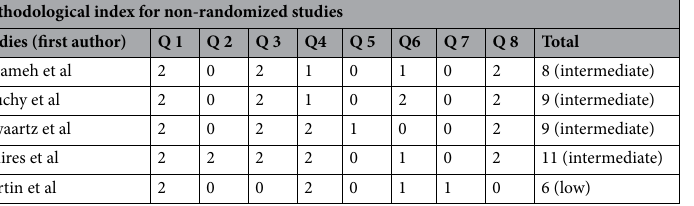
Table 3. Risk of bias assessment for included non-randomized studies. Q1 Did the study have a clear aim? Q2 Were consecutive patients included? Q3 Were data collected prospectively? Q4 Were endpoints appropriate to the study? Q5 Was there an unbiased assessment of endpoints? Q6 Was the follow-up period adequate? Q7 Was loss to follow-up less than 5%? Q8 Was there a prospective calculation of study size? 0, Not reported; 1, reported but inadequate; 2, reported and adequate. Overall score rating: > 12, high; 8–12, intermediate; < 8, low.